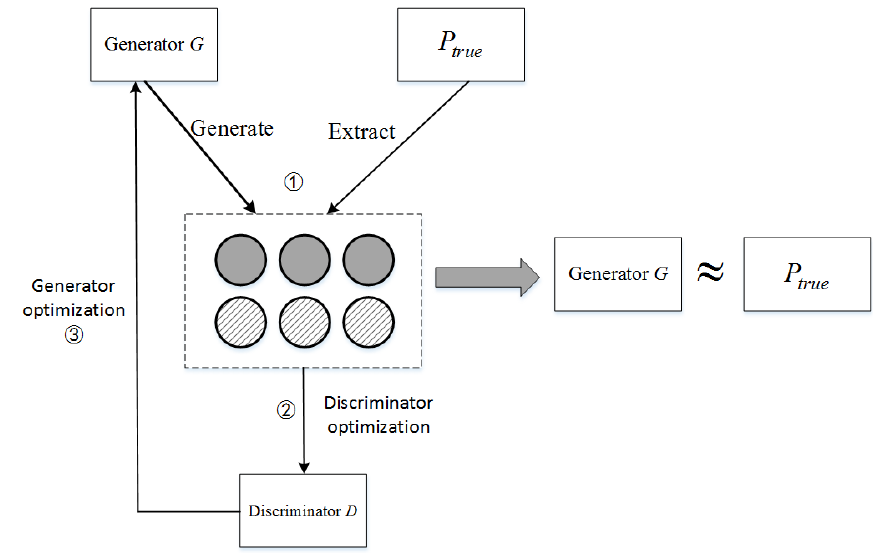
Figure 5. EmbedGAN algorithm framework.